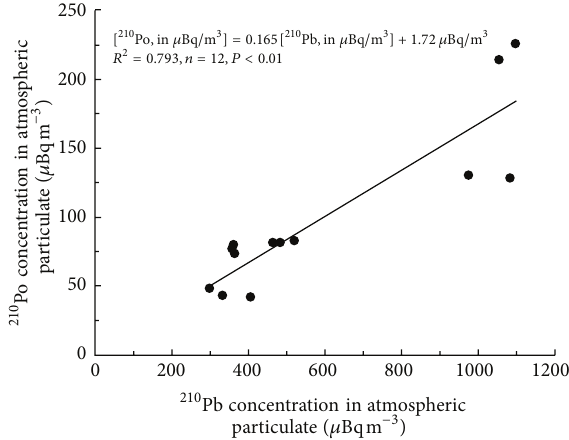
Figure 3: Correlation between 210 Po and 210 Pb concentrations in atmospheric particulate collected at site ILVA Taranto.